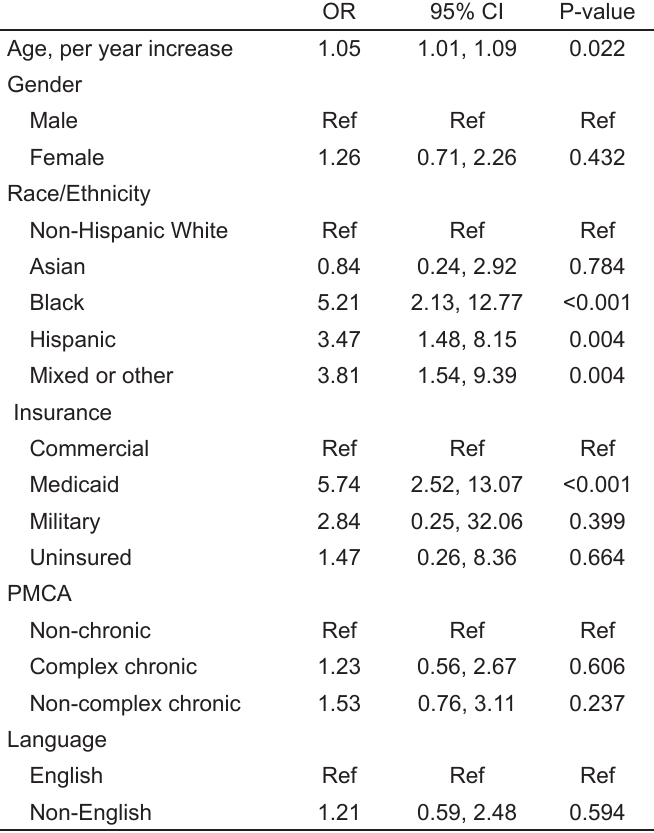
OR, odds ratio; CI, confidence interval; PMCA, patient medical complexity